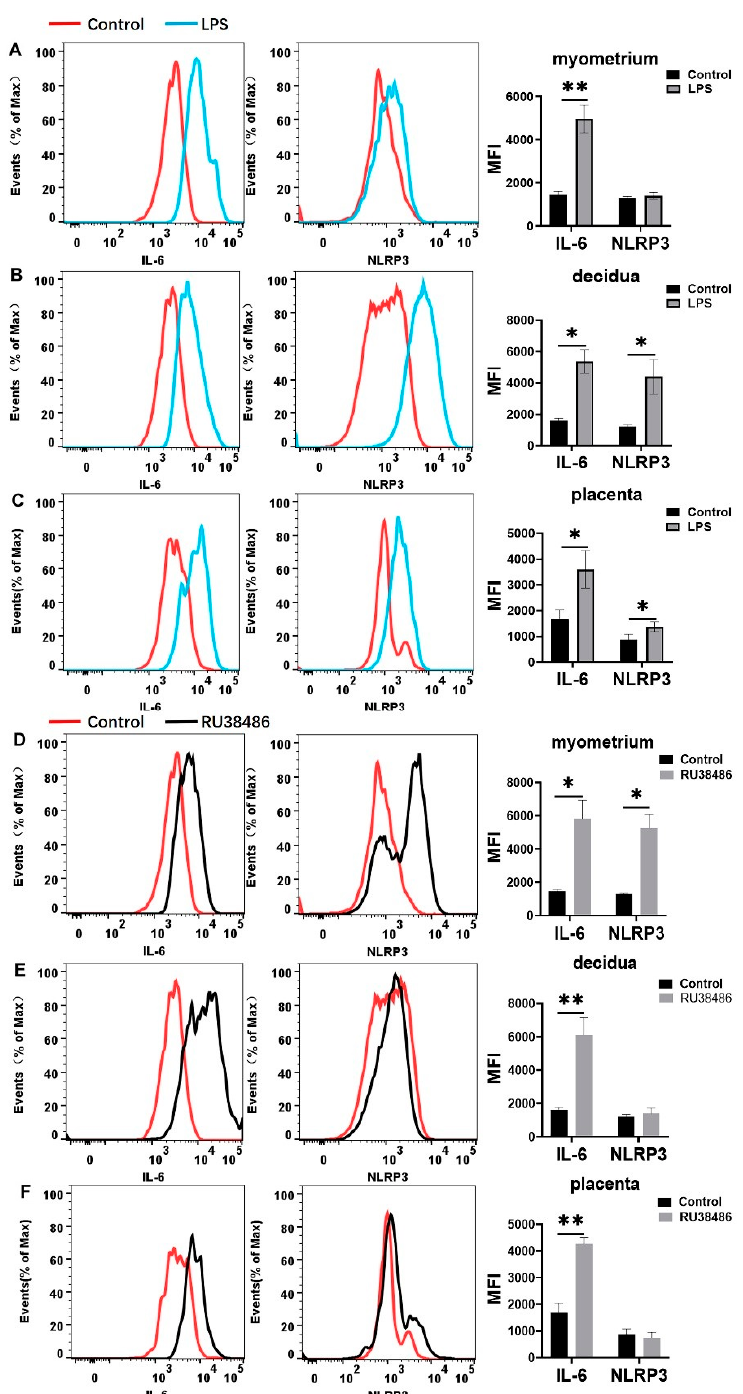
Figure 8. IL-6 and NLRP3 expression in gestational tissues at preterm labor induced by LPS and RU38486. Pregnant mice were administered LPS ( A – C ) at GD16.25 or RU38486 ( D – F ) at GD16. The mice with LPS or RU38486 were sacrificed after the onset of labor. The control mice were administered the same volume of saline and sacrificed at the corresponding time of LPS or RU38486 group. ( A , D ) Flow cytometry of IL-6 and NLRP3 expression in myometrium. ( B , E ) Flow cytometry of IL-6 and NLRP3 expression in decidua. ( C , F ) Flow cytometry of IL-6 and NLRP3 expressions in placenta. Representative flow cytometry evaluating IL-6 and NLRP3 expression (the left panel) and statistics calculated by the MFI of IL-6 and NLRP3 (the right panel) from macrophages (CD11b+F4/80+) in myometrium or decidua or placentas. Data are expressed as mean ± SEM. n = 5 in each group. * p < 0.05, ** p <